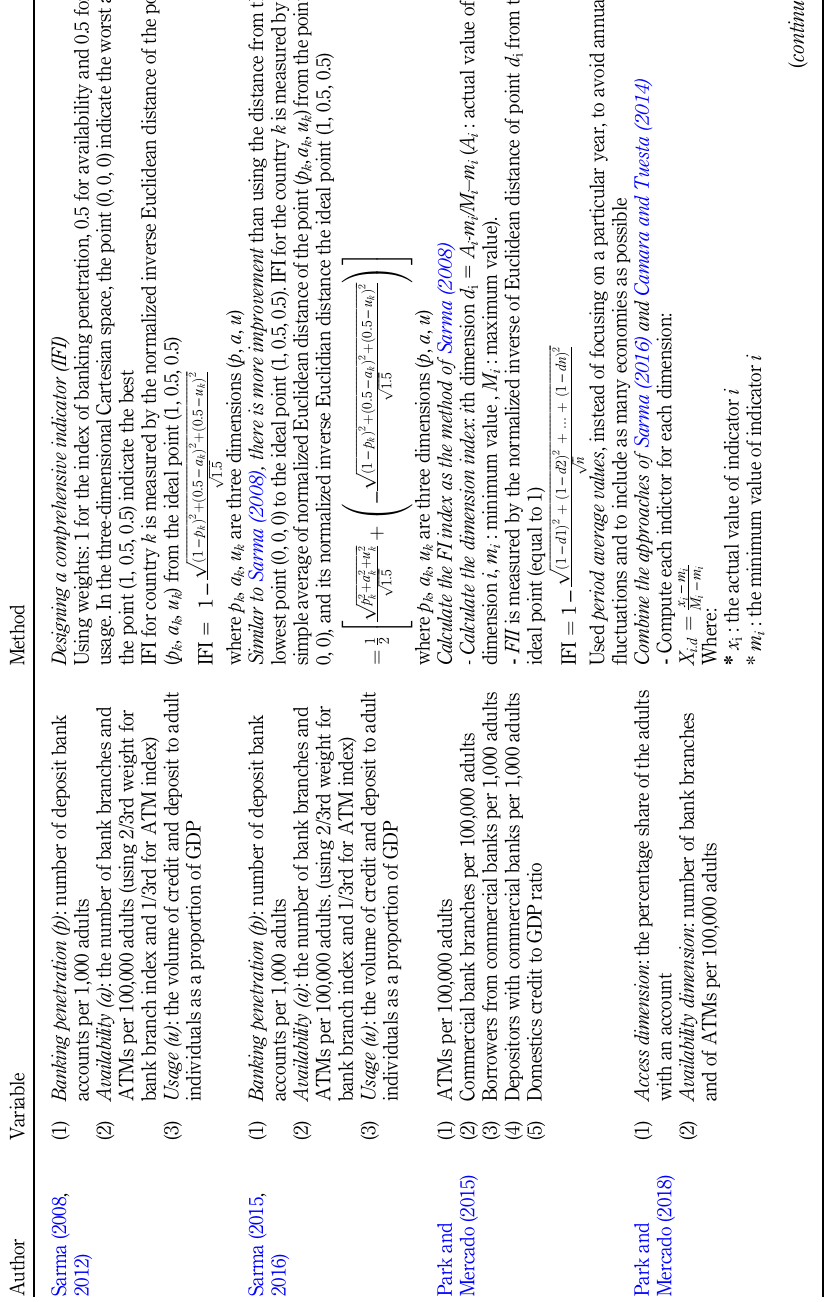
Table A9. Summary of variables and methods of FI measurement from related